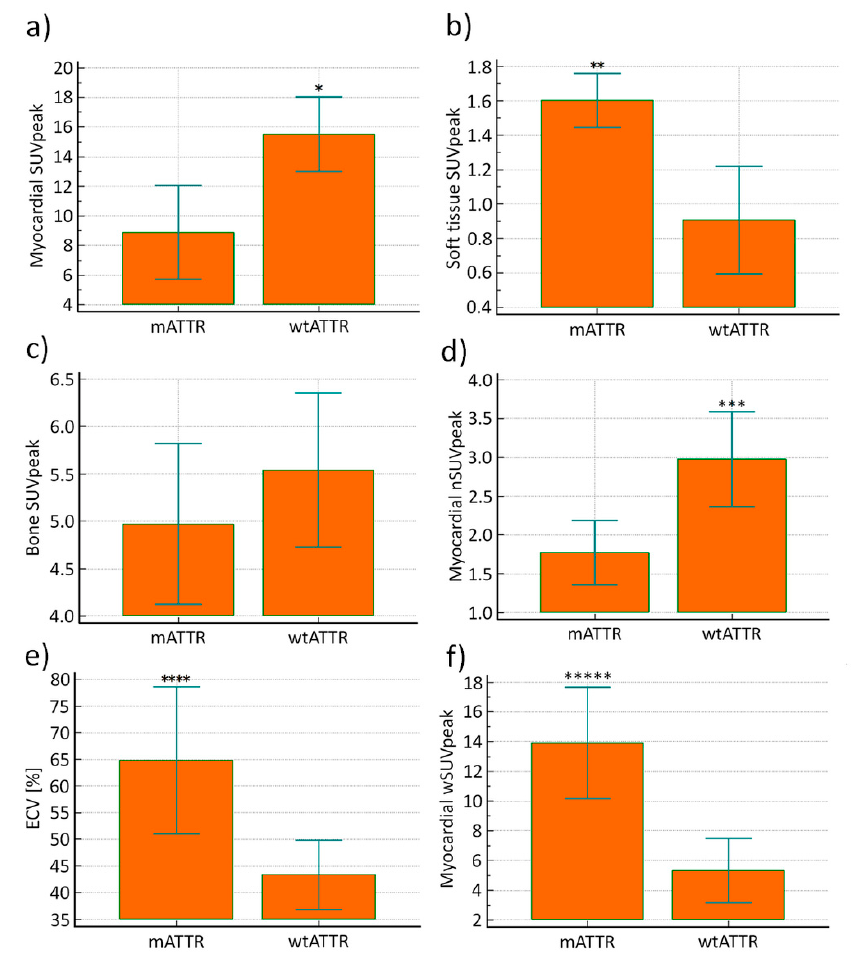
Figure 5. Genetic correlations. ( a ) Myocardial SUVpeak was significantly increased in patients with wtATTR compared to patients with mATTR (* p = 0.003). ( b ) In contrast soft tissue SUVpeak was significantly increased in patients with mATTR (** p = 0.005). ( c ) Furthermore, there was no significant difference found for bone SUVpeak between patients with wtATTR and mATTR ( p = 0.36). ( d ) Myocardial nSUVpeak was significantly increased in patients with wtATTR (*** p = 0.01). ( e ) ECV (***** p = 0.008) and ( f ) Myocardial wSUVpeak (***** p = 0.0001) were significantly increased in patients with mATTR, respectively.